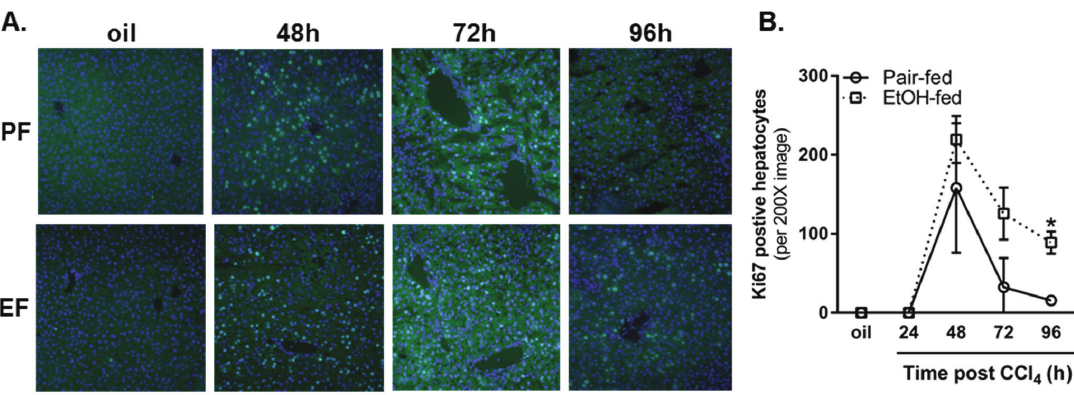
Figure 8. Moderate ethanol feeding to mice sustained hepatocyte proliferation late in the time course after CCl 4 exposure. ( A ) Representative images from Ki67-stained livers from pair- and ethanol-fed mice by immunofluorescense (green) after CCl 4 . DAPI (blue) was used as a nuclear counterstain. Sections were stained on the same day and exposure times kept constant for each image; ( B ) Quantification of the number of Ki67-positive hepatocyte nuclei in 3–4 images from a single liver section per mouse. PF = Pair-fed, EF = Ethanol-fed. N = 3–4 mice per group. * p < 0.05.